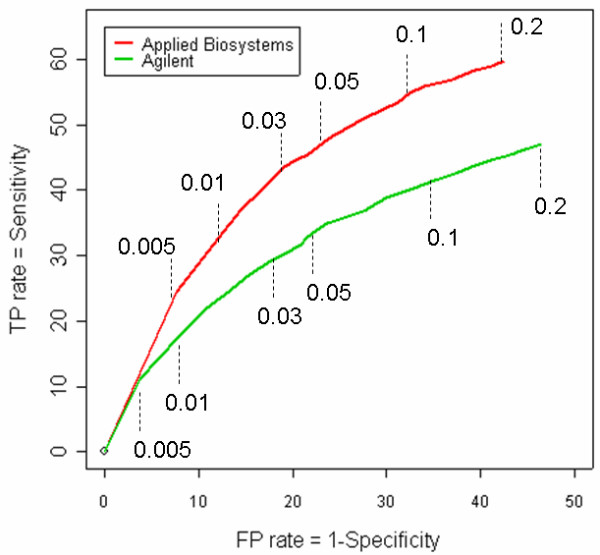
ROC curve for accuracy in detection of differential expression at different FDR thresholds. Significantly differentially expressed genes are defined as p < 0.05 in student t-test using TaqMan Gene Expression data set as a reference. For each microarray platform, on top of the p-value criteria (p < 0.05 in student t-test), a series of FDR (0–20%) were also applied to achieve increasing stringency. Each point on the ROC curve of a given microarray platform represents the sensitivity (true positive rate) and 1- specificity (false positive rate) at a given FDR level (labeled on dashed lines).